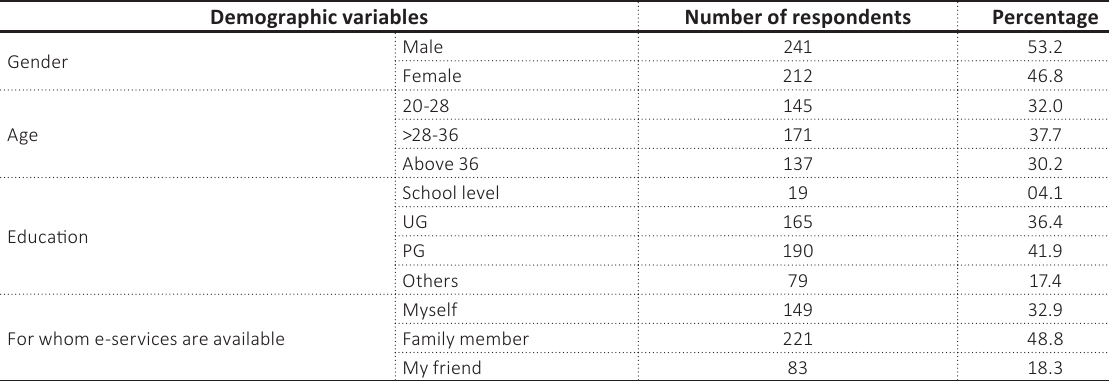
Table 1. Demographic profile of respondents Demographic